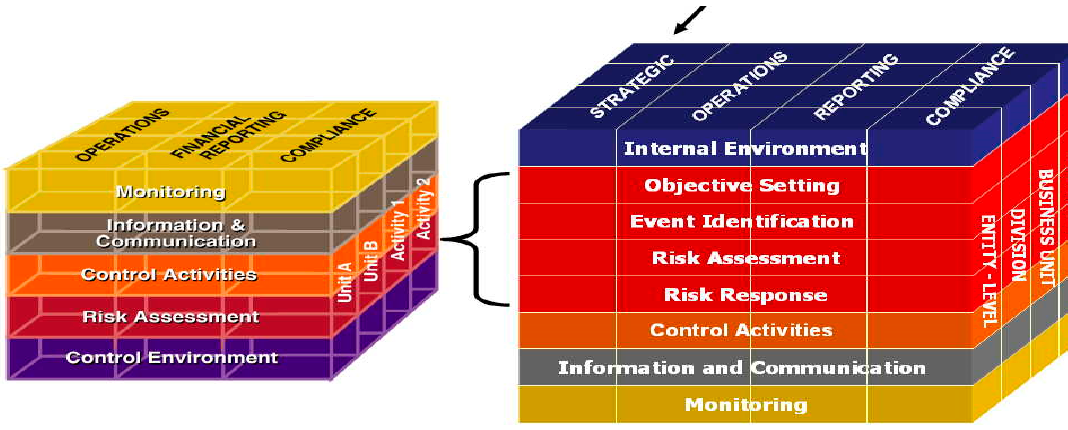
Figure 1. Committee of Sponsoring Organizations of the Treadway Commission (COSO) Updated internal control and Enterprise risk management framework, as cited in (Jill and Houmes 2014).